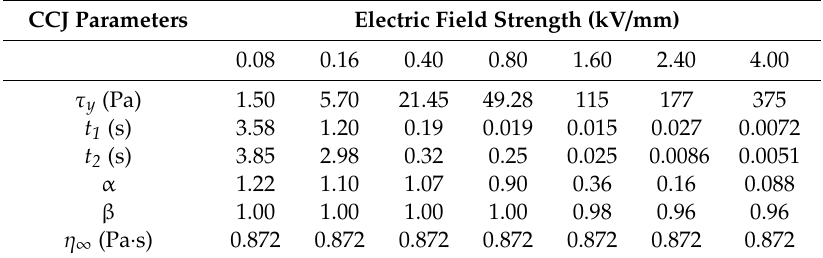
Figure 5. Steady state flow curves at 25 °C for 4 wt.% dispersions of ( a ) cellulose nanocrystals, CNC, and ( b ) cellulose nanofibrils, CNF, in castor oil, as a function of electric field strength. Table 1. Fitting parameters of Equation (1) for the 4 wt.% cellulose nanofibrils (CNF) dispersion in castor oil, at the di ff erent electric field strengths